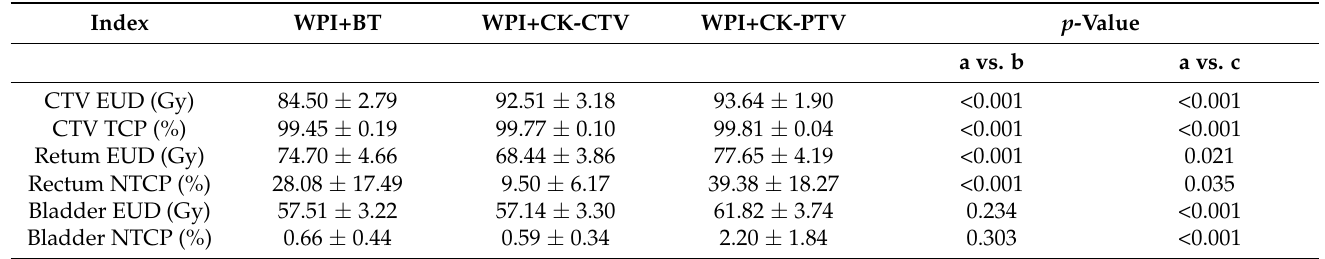
Table 4. Radiobiological comparison of CTV and OARs in the WPI+BT, WPI+CK-CTV and WPI+CK- PTV